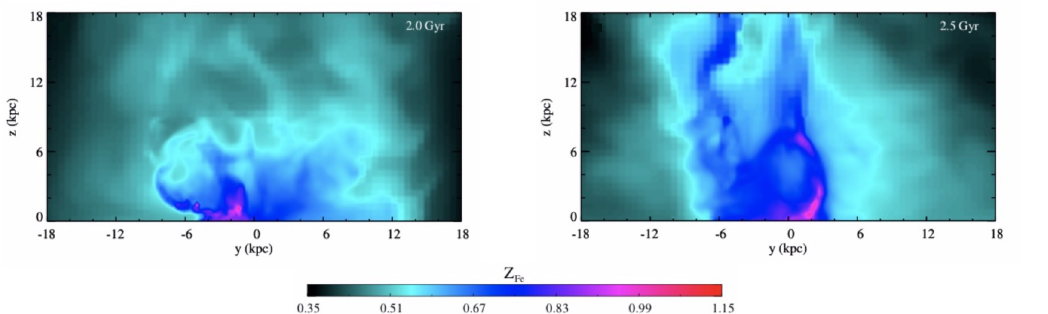
Figure 10. Emission-weighted iron abundance during a typical HR HD 3D simulation of self-regulated AGN feedback in a median 1keV galaxy group akin to NGC5044 (adapted from Gaspari et al. [215]), showing two typical stages. The black regions denote the diffuse, primordial iron background ( Z Fe < 0.3 Z (cid:12) ). ( Left ) turbulence-driven period, during which mixing dominates, gradually washing out the anisotropic features and restoring azimuthal symmetry. ( Right ) the meso-scale (sub-kpc) AGN outflows have inflated a common X-ray cavity in the IGrM, generating a thin metal-rich rim (coincident with the compressive cocoon shock) and anisotropic iron uplift from the BGG outwards in the extended IGrM.